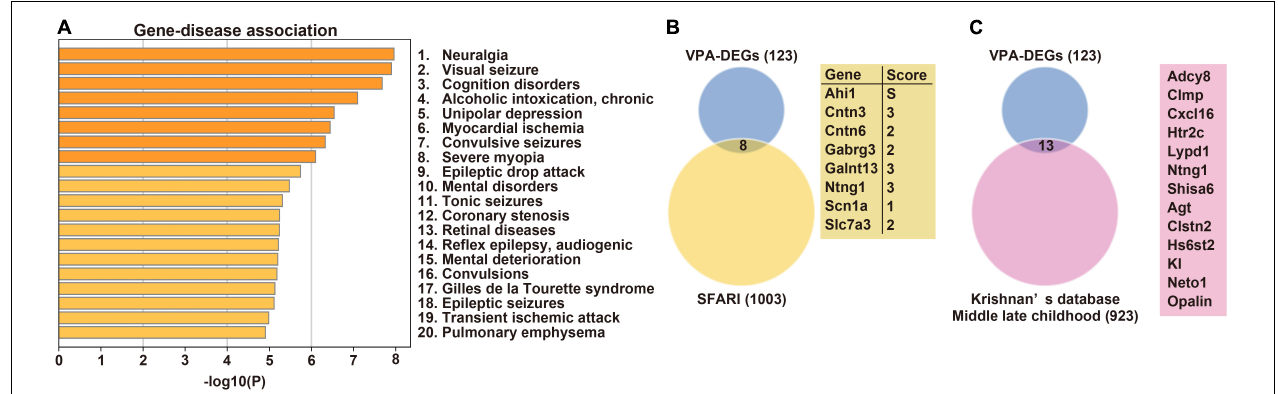
FIGURE 2 | Disease-associated profiling and overlap with ASD candidate genes. (A) Association between DEGs and human diseases. Venn’s diagrams depict overlap between DEGs and candidate genes for ASD registered in SFARI (B) and Krishnan’s database (C) , respectively. ASD, Autism spectrum disorder; DEG, differentially expressed gene.